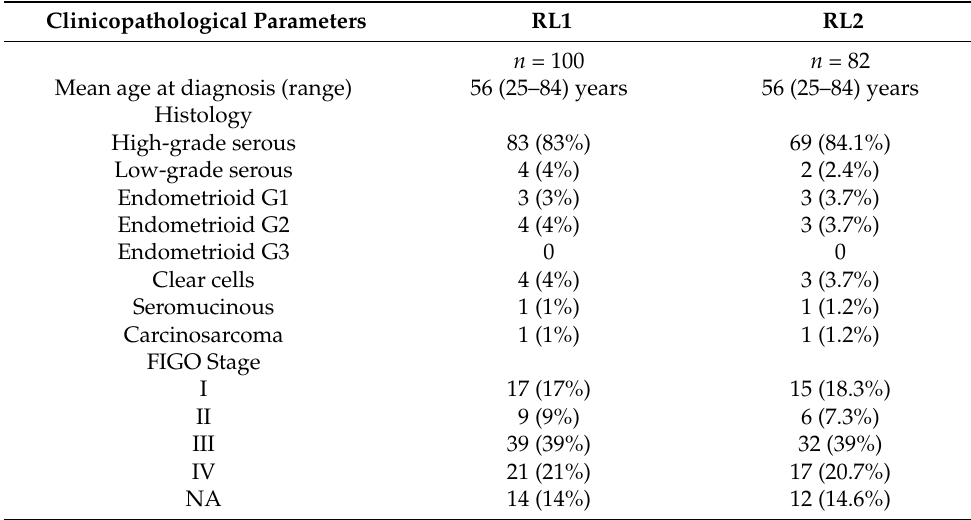
Table 1. Patient demographic and clinical characteristics. Clinicopathological